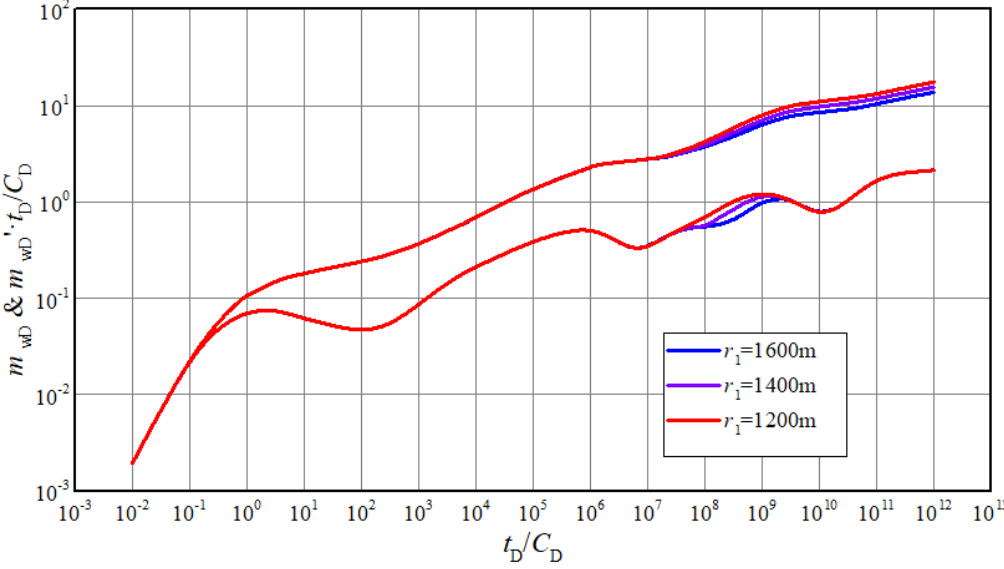
Figure 10. The e ff ect of radius of inner region on transient pseudo-pressure and derivative curves.